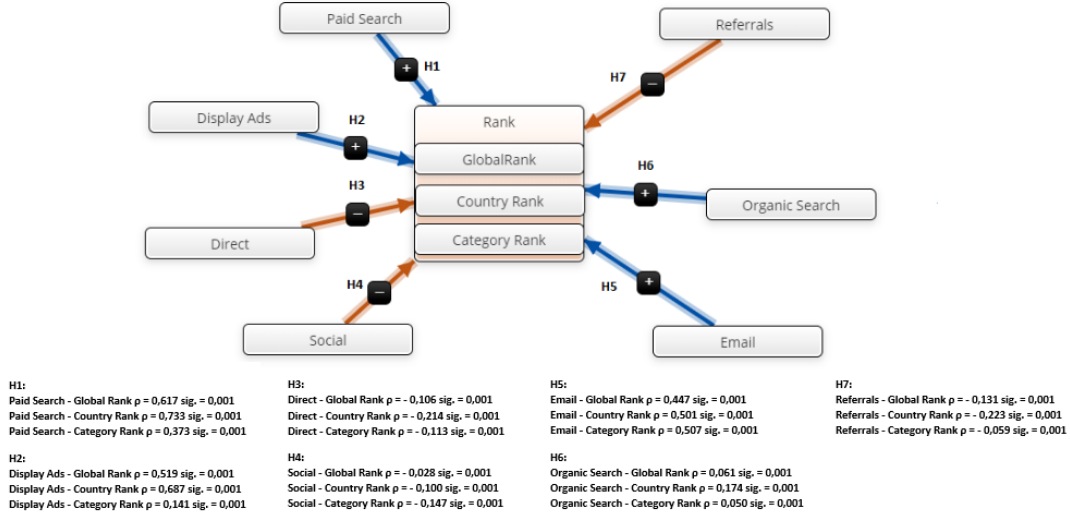
Figure 1. Descriptive representation of the correlations obtained between the ten-web analytics metrics through FCM.